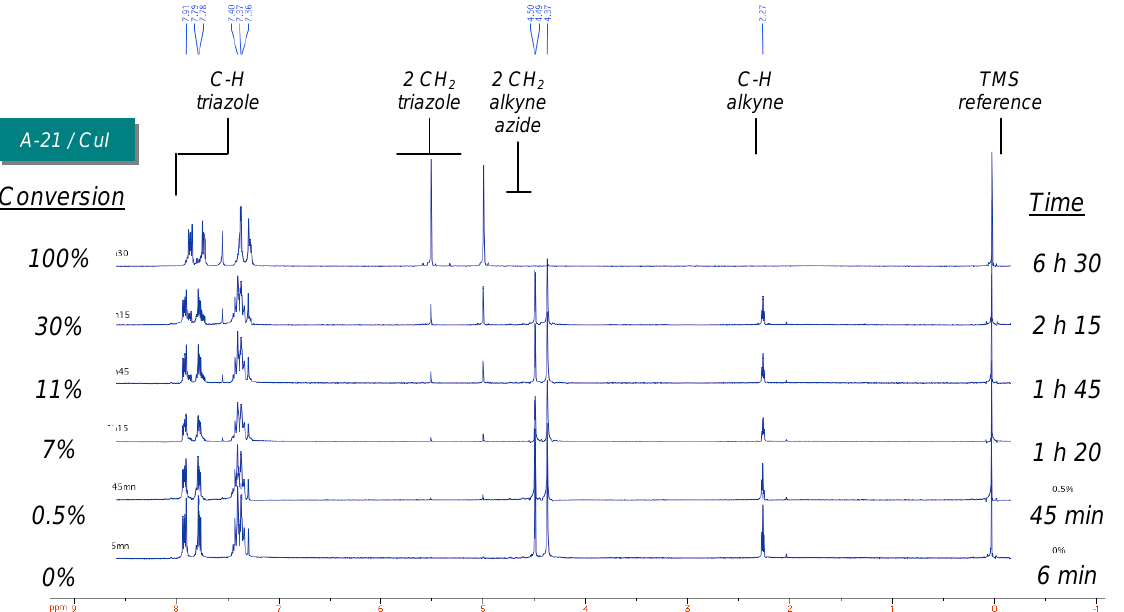
Spectra recorded at 300 MHz in 1 mL CDCl 1 and 0.55 mmol azide